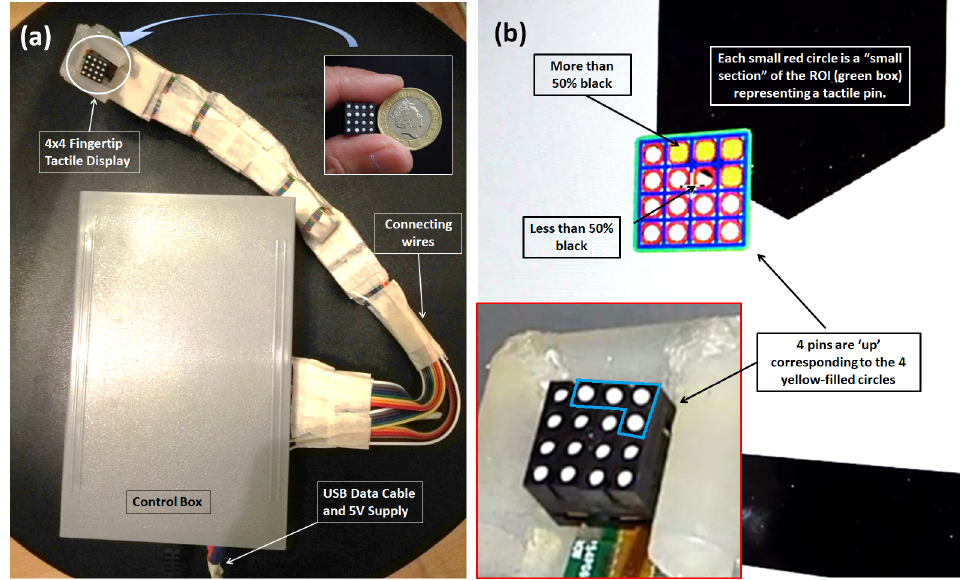
Figure 3. Our initial miniaturized fingertip module presented in 2020, 4 × 4 fingertip tactile ma- trix actuator with edge detection scanning ROI simulator presented in [55]. ( a ) Hardware setup, ( b ) graphical user interface